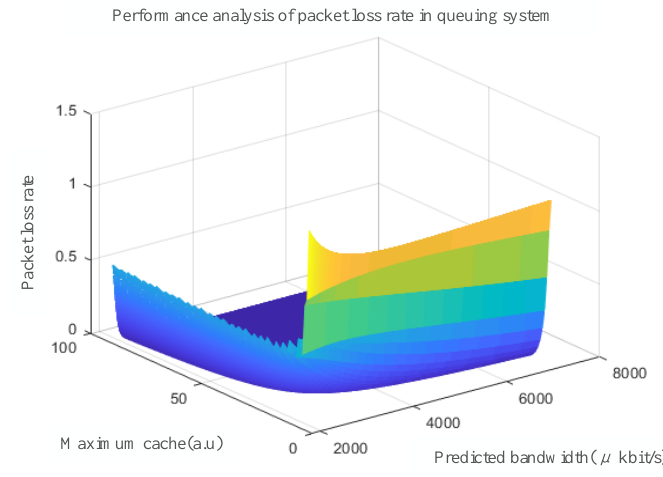
Figure 5. Performance analysis of packet loss rate in the queuing system.